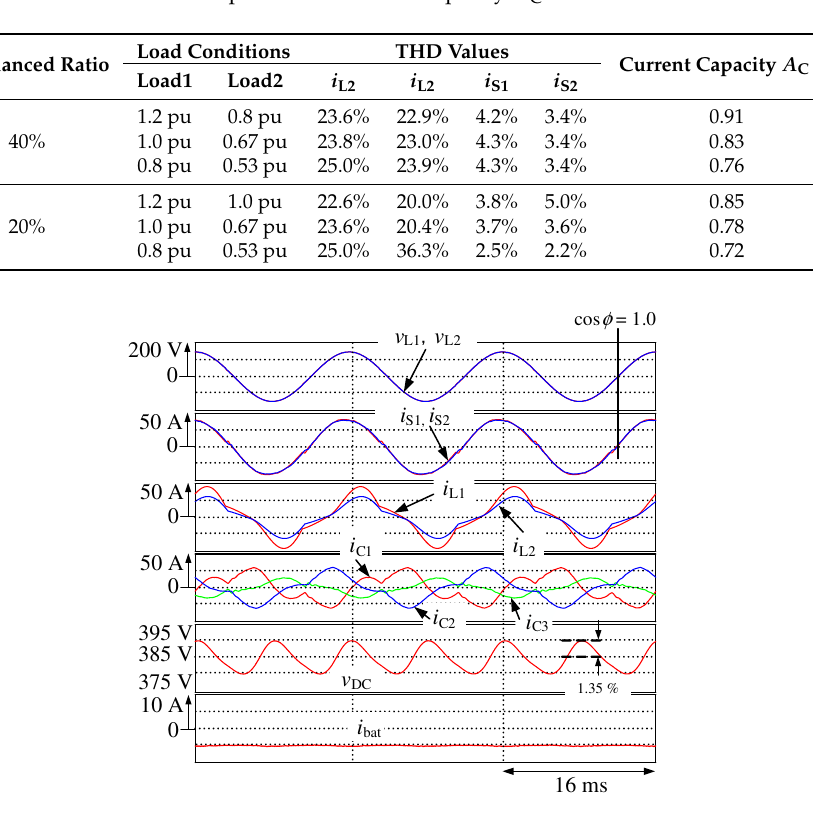
Table 2. Relationships between current capacity A C and load conditions.